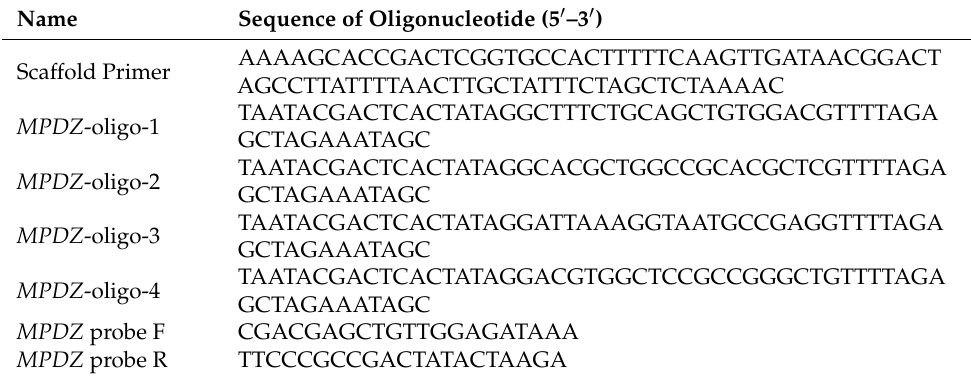
Table 1. Primers used for MPDZ